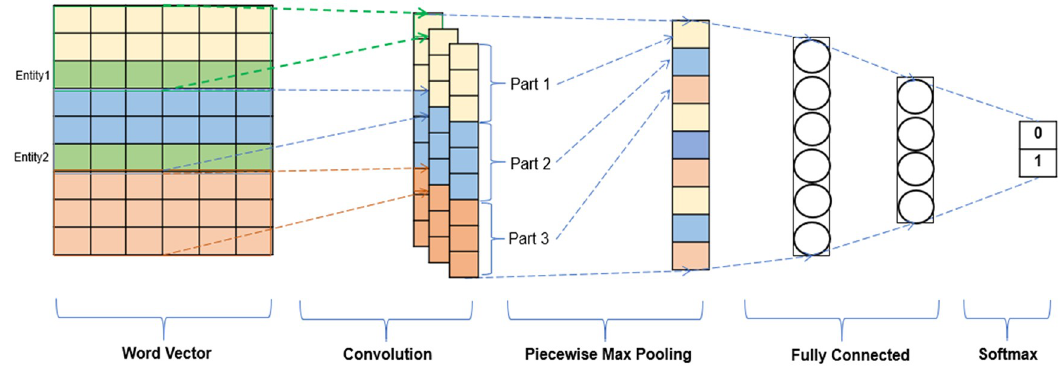
Fig 1. Structure of piecewise CNN model.